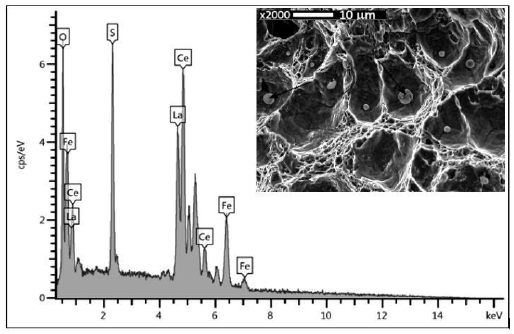
Figure 17. X-ray spectrum of inclusions on fracture